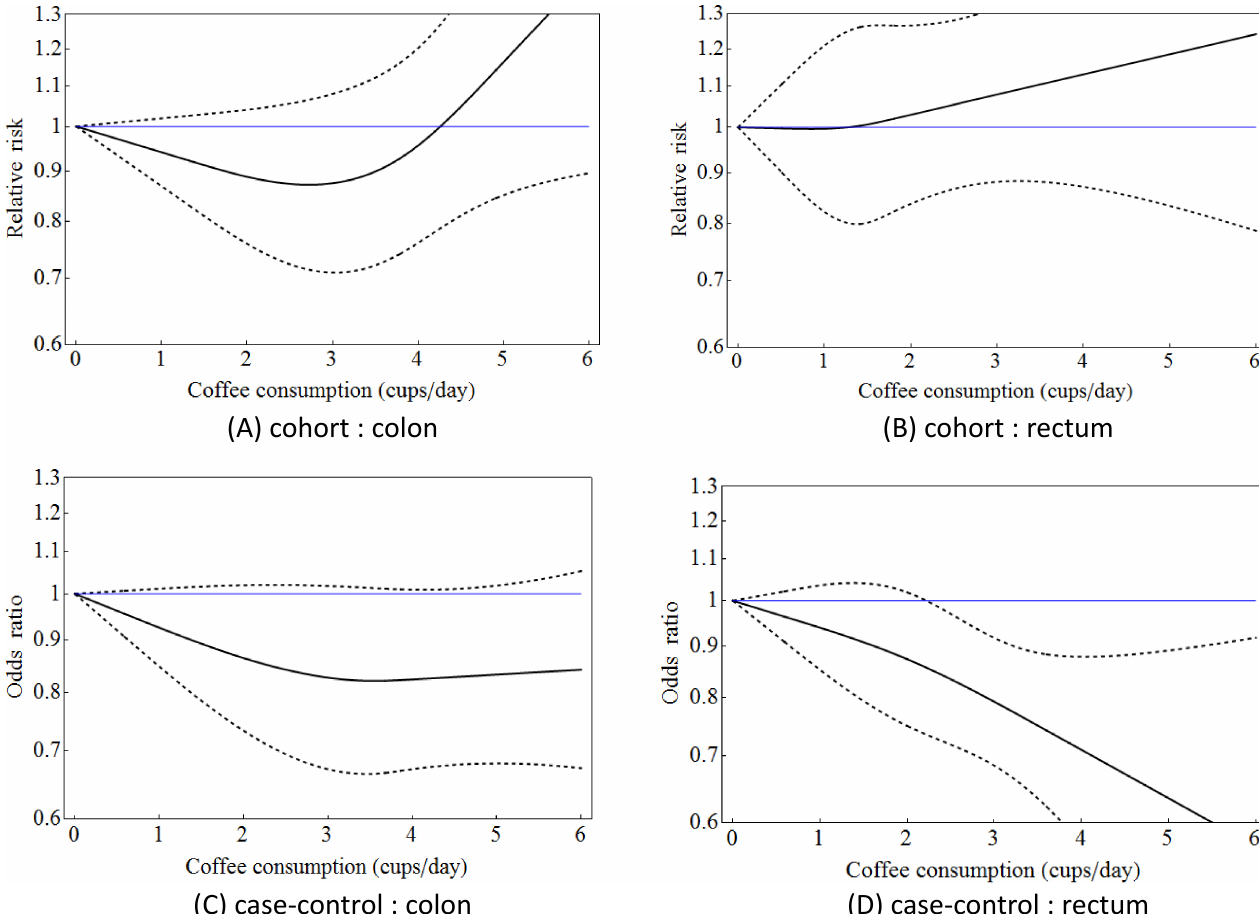
Figure 2. Dose-response curves of colorectal cancer risks associated with co ff ee consumption in the Japanese population for colon (A) and rectum (B) (meta-analysis based on cohort studies), and for colon (C) and rectum (D) (meta-analysis based on case-control studies). Dashed curves represent 95% con fi dence intervals for each value of co ff ee